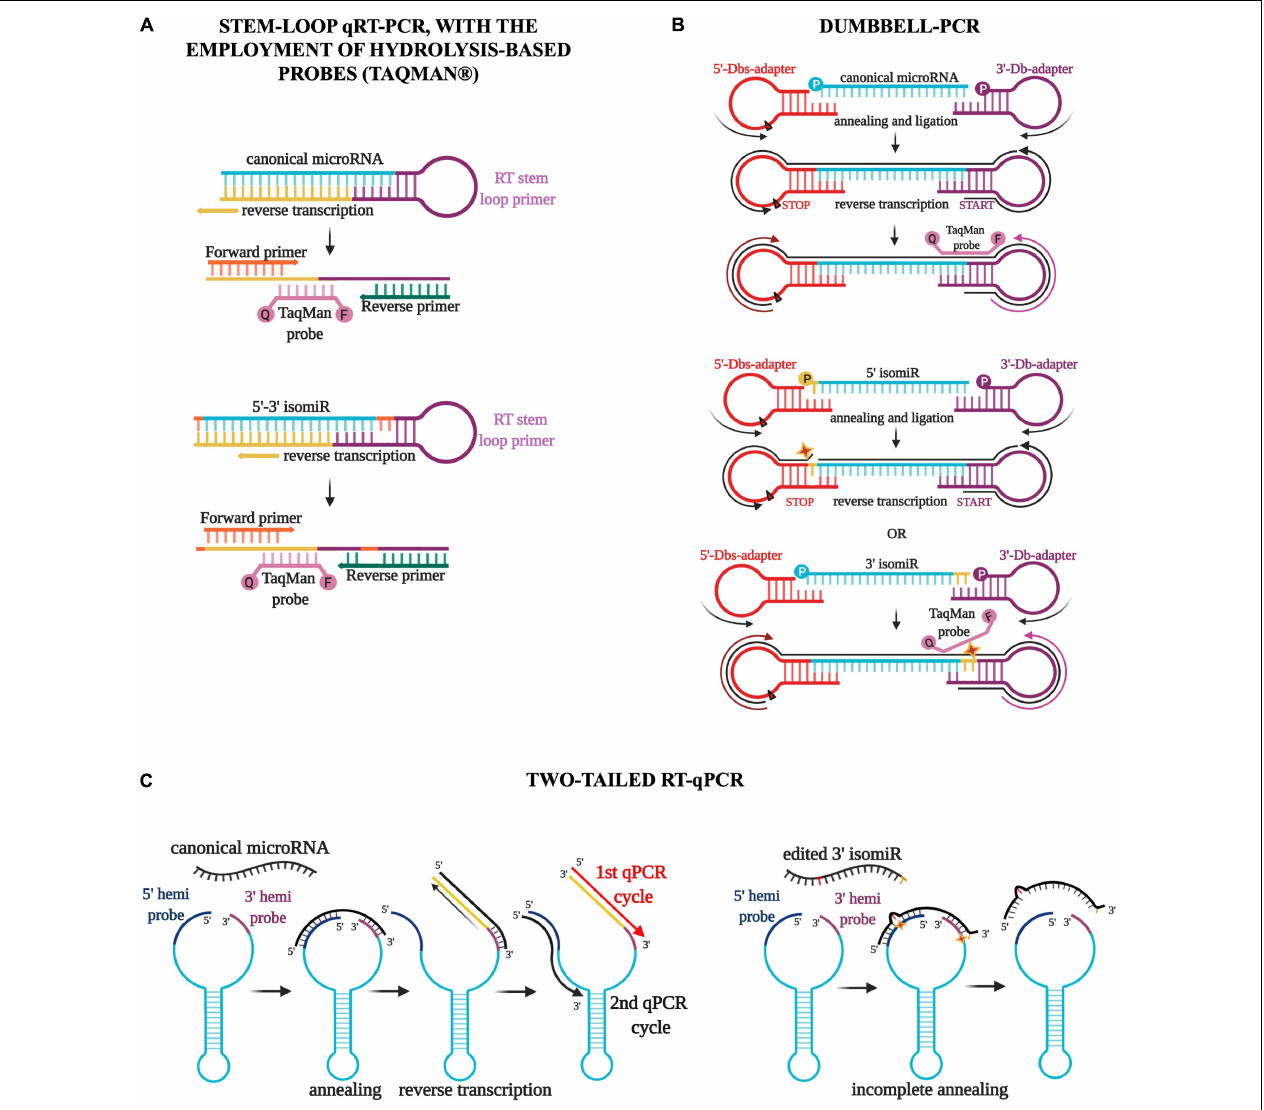
FIGURE 3 | Three different qPCR techniques for the detection of isomiRs. (A) The stem-loop qRT-PCR, with the employment of hydrolysis-based probes (Taqman), has become the most commonly used commercial technique. However, this method has significant limitations in detecting and quantifying isomiRs accurately. The discrimination of two sequences that differ by only one or a few nucleotides is not guaranteed by this protocol and must be established empirically for each molecule using customized probes and appropriate controls. (B) Dumbbell-PCR employs a 3 (cid:48) -stem-loop adapter, which acts as the reverse transcription trigger, and a 5 (cid:48) -stem-loop adapter, which contains a stop signal for reverse transcription. IsomiR gaps or overlaps strongly impact the efficacy of the ligation process and the annealing of a Taqman probe partially complementary to the microRNA and partially to the 3 (cid:48) adapter sequences. (C) Two-tailed RT-qPCR is characterized by the design of a long-structured primer ( ∼ 50 nucleotides) holding two hemiprobes complementary to the 5 (cid:48) and 3 (cid:48) ends of the microRNA. The reverse transcription starts from the 3 (cid:48) end, extending the primer sequence with the complementary sequence of the target microRNA and simultaneously detaching the 5 (cid:48) end.